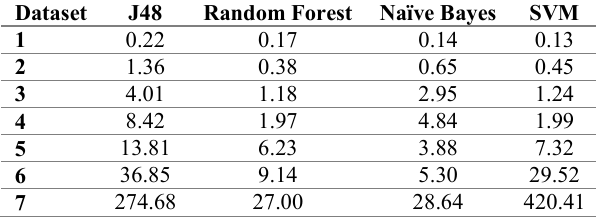
Table 7. Comparison of CPU time (seconds) taken for model training